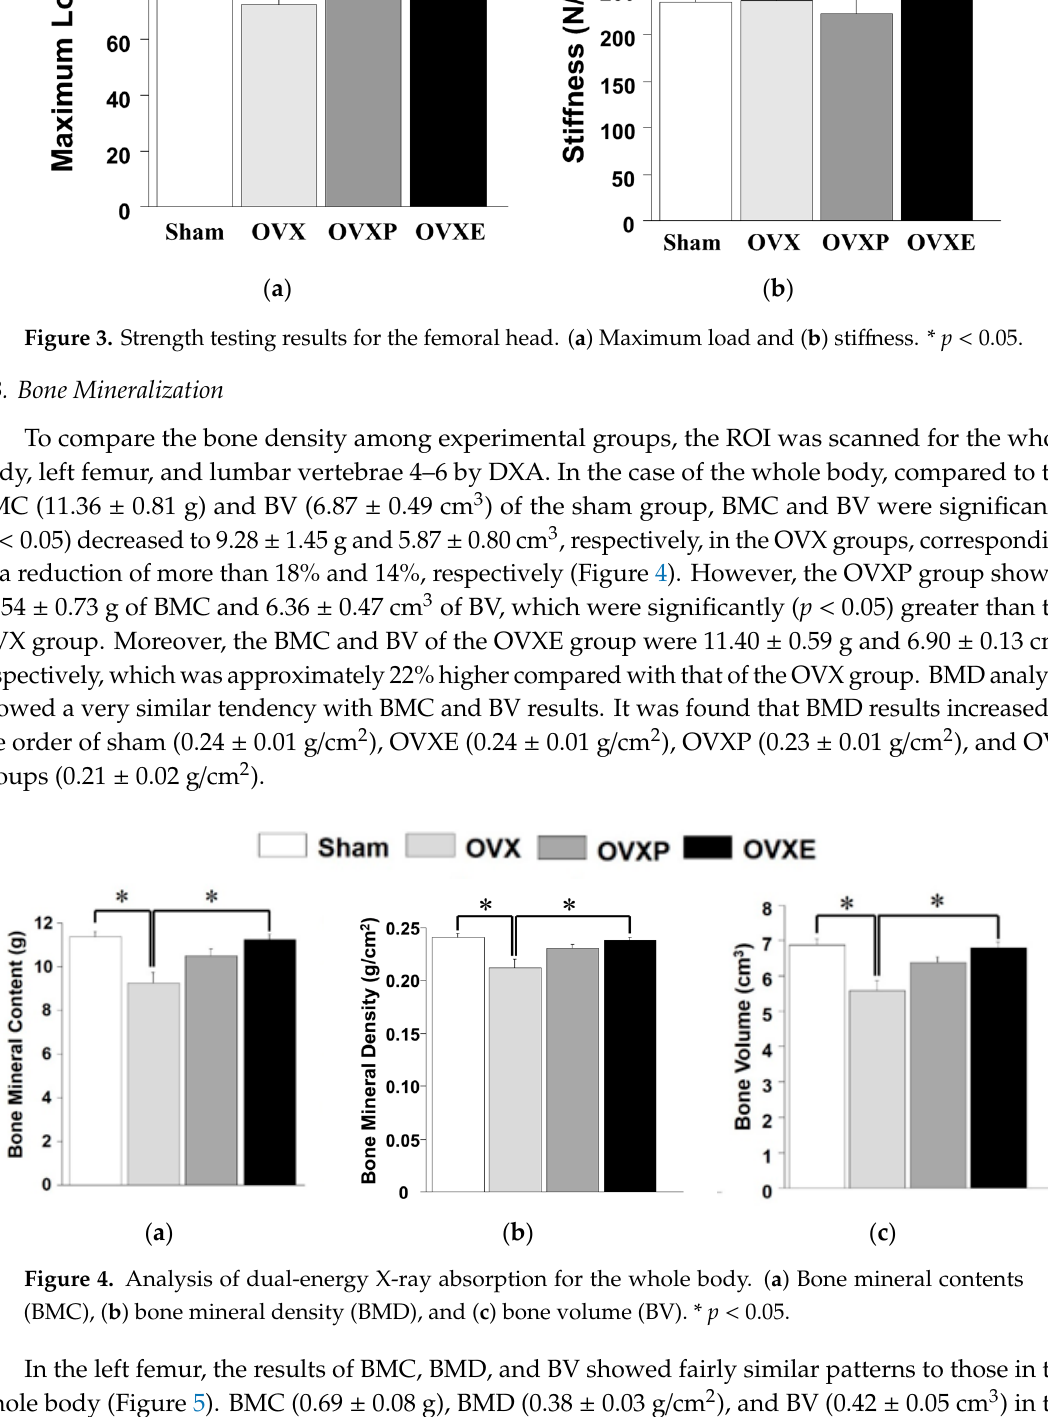
( c ) Figure 5. Analysis of dual-energy X-ray absorption for the left femur. ( a ) Bone mineral contents (BMC), ( b ) bone mineral density (BMD), and ( c ) bone volume (BV). * p < 0.05.